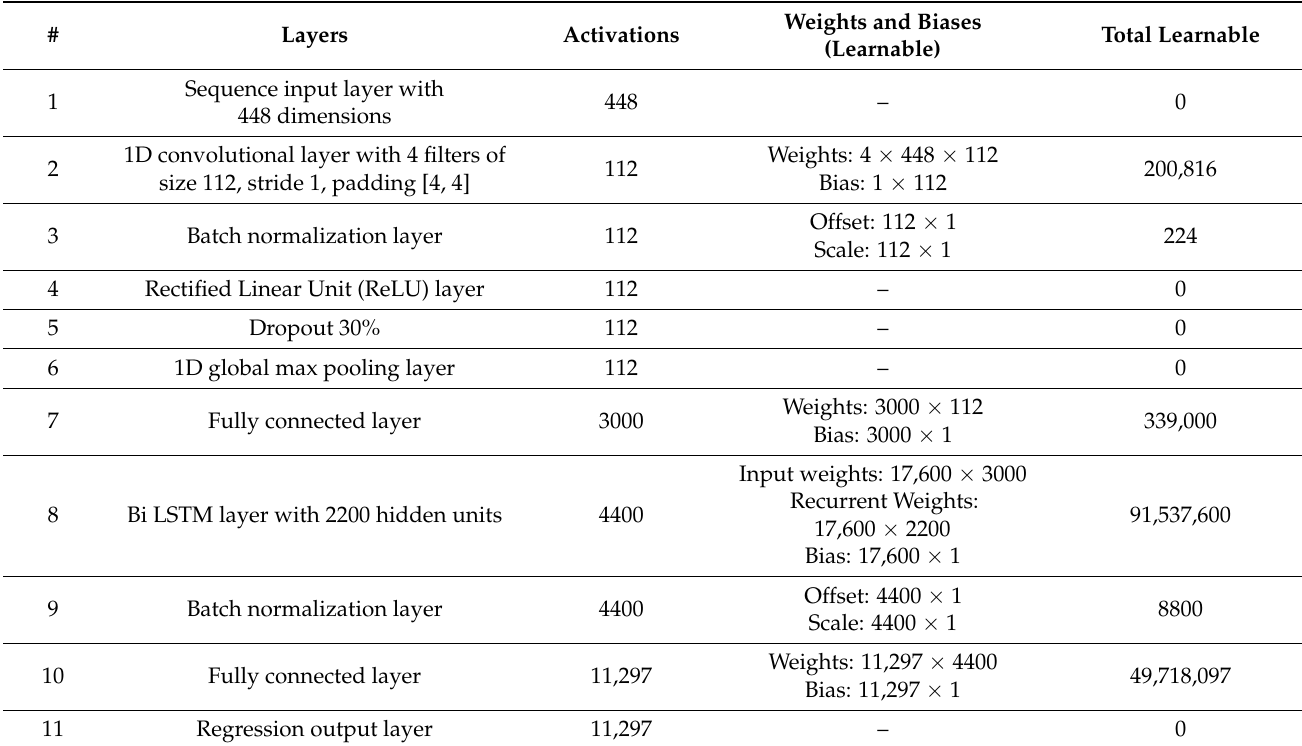
Table 4. Layers of the CNN+LSTM hybrid neural network.